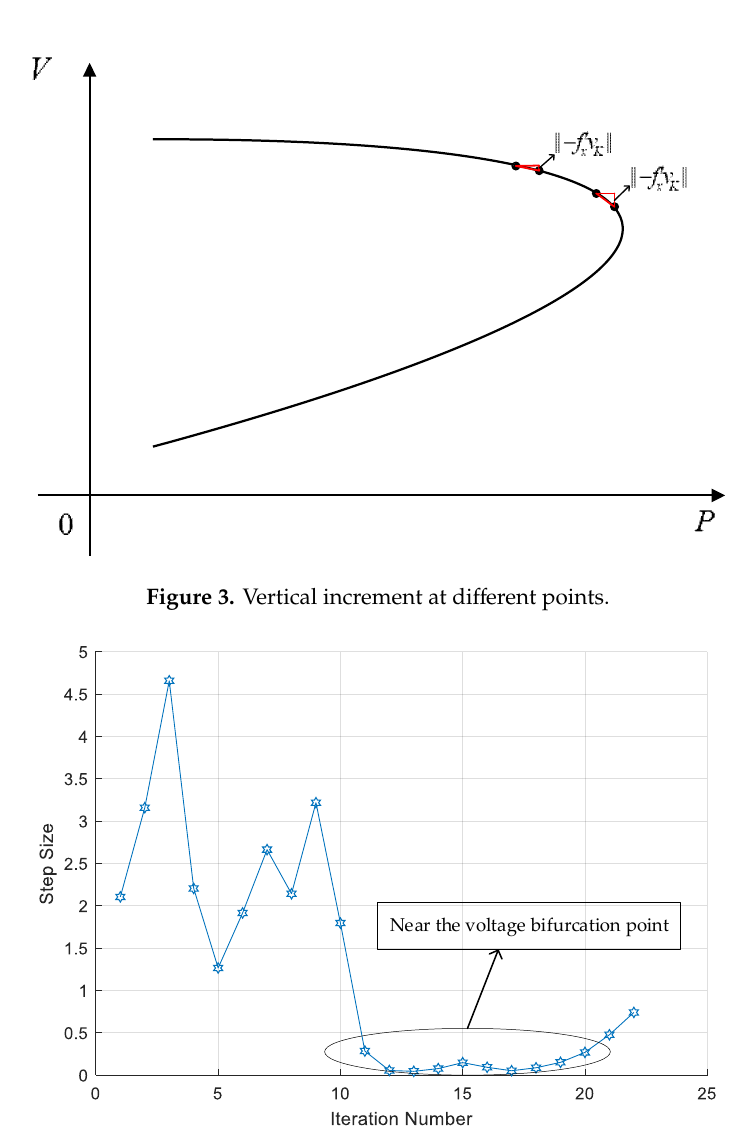
Figure 4. Maximum step size at different points.